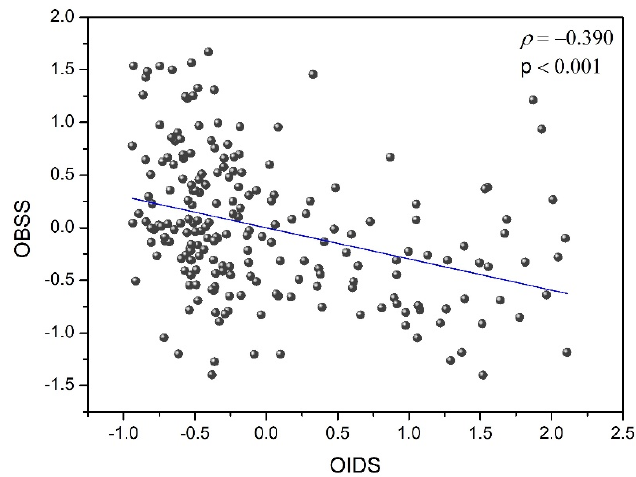
Figure 2. The overall binocular summation score (OBSS) of the visual function as a function of the overall interocular difference s/core (OIDS) under the two experimental conditions (baseline and after alcohol intake).